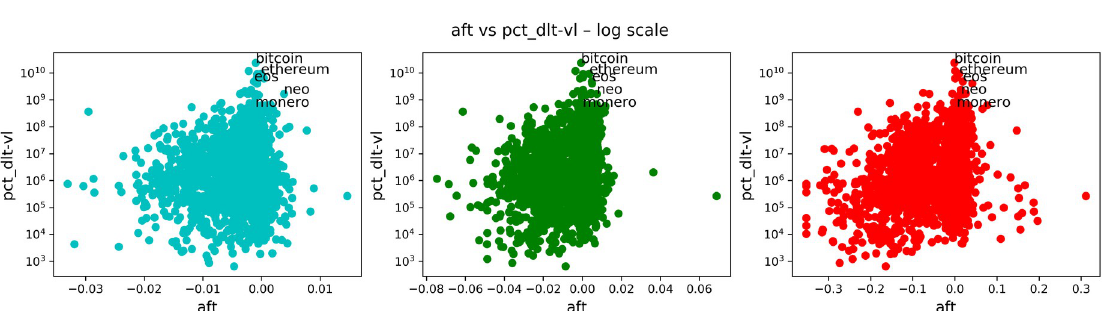
Fig 9. Comparison of anti-fragility values and pct_dlt-vl in cryptocurrencies. Each subplot corresponds to a timescale. The plots compare the corresponding A measure (x-axis) to the ‘good-performance’ measure pct_dlt-vl . We observe how higher values of the ‘good- performance’ measure concentrate in the robust axis A = 0 .